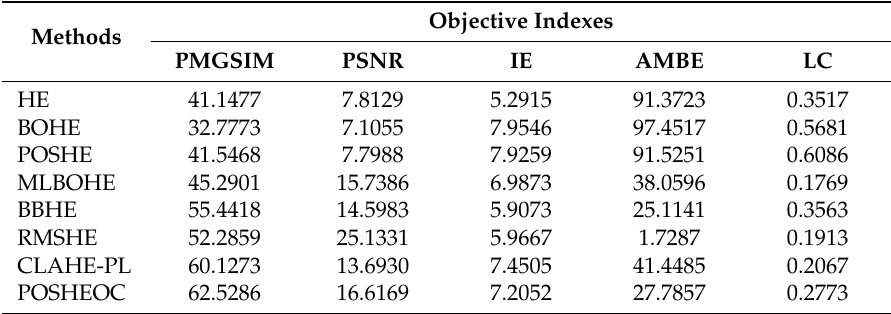
Table 1. Quantitative results for ultrasonic logging image of model well with various methods.